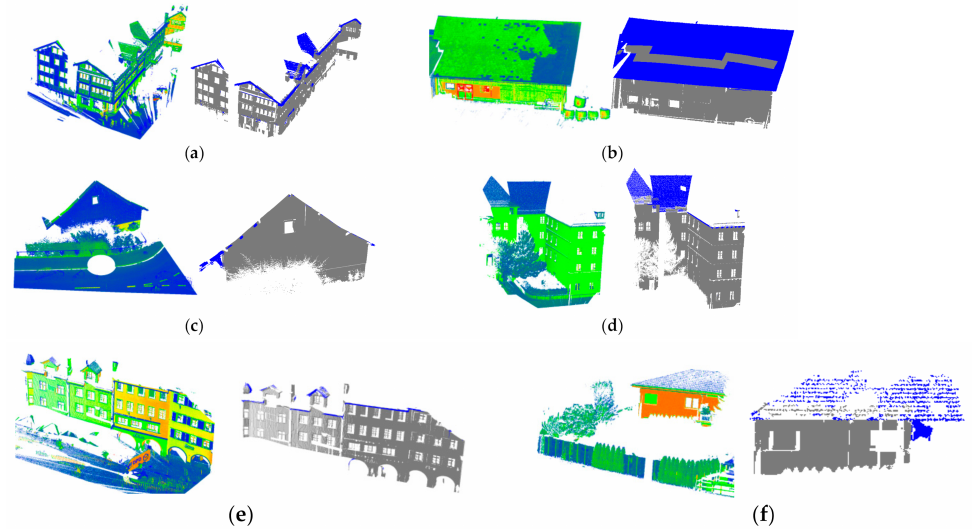
Figure 18. Extraction details of separating building points from non-building points in Semantic3D. Separated targets are ( a ) pedestrian, ( b ) bucket, ( c , d ) vegetation, ( e ) van and ( f ) wall. For each sub-figure, the left side shows the original points rendered by intensity, while the right shows the extraction result with facade points colored gray and roof points colored